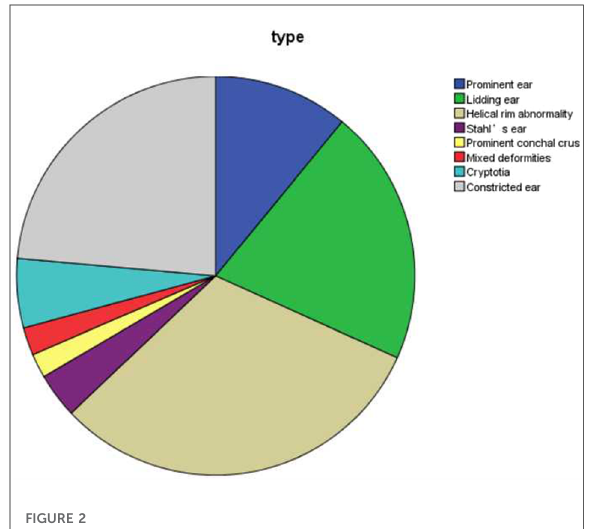
FIGURE 2 Type of congenital ear deformities in 356 ears.